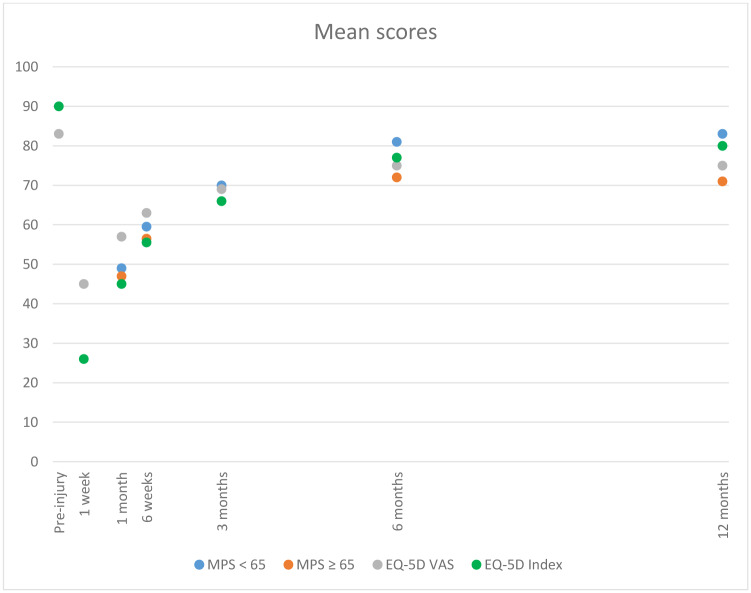
Mean EQ-5D VAS, index score* and MPS over time.*To combine all questionnaires in one figure, the results of the EQ-5D index are multiplied by a hundred (“x 100”).